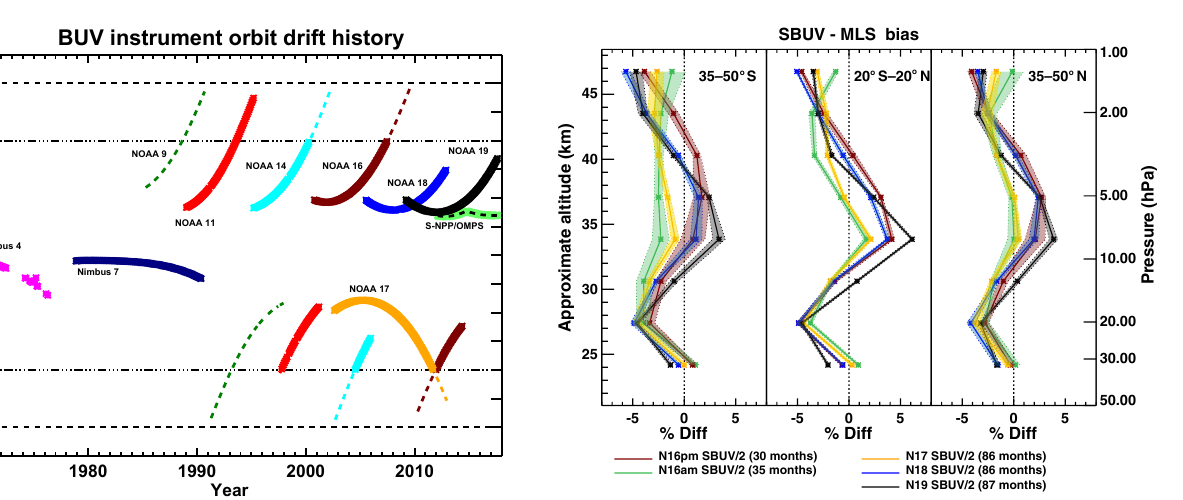
Figure 2. Mean bias of SBUV instruments (N16–N19) relative to Aura MLS in percent computed over respective overlap periods for each instrument. Results shown are averaged in three broad latitude bands: 35–50 ◦ S, 20 ◦ S–20 ◦ N and 35–50 ◦ N. Shaded areas indicate 2 σ deviations computed from the monthly